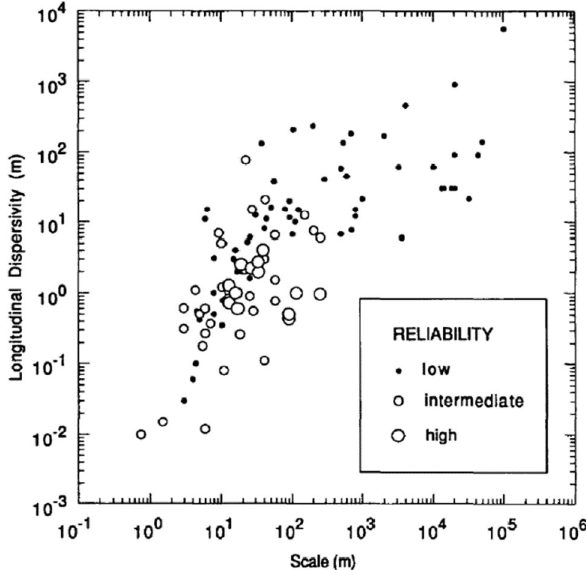
Fig. 3 Longitudinal dispersivity against scale with data classified by reliability (Gelhar et al.